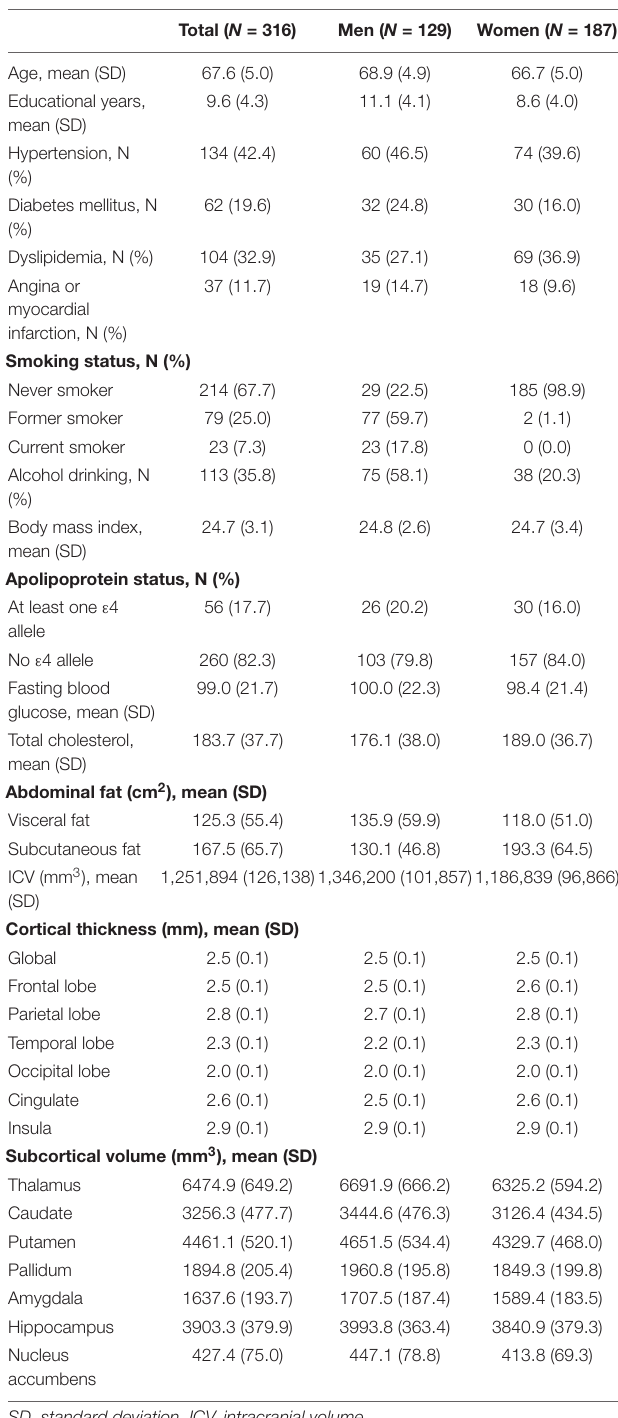
TABLE 1 | Characteristics of the study